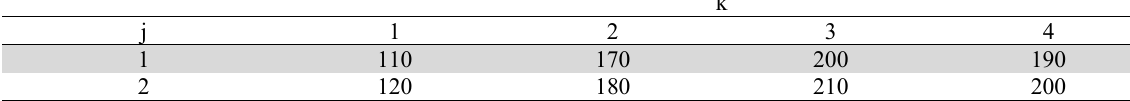
Distance between plants and distribution centers(d jk )(km)